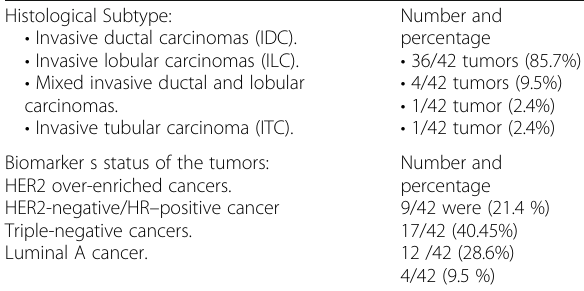
Table 3 Histopathological and molecular subtypes of the patients enrolled in the